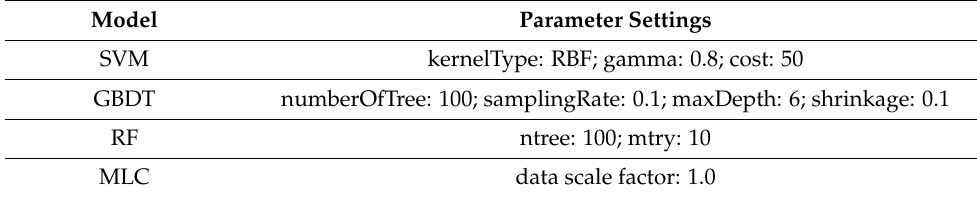
Table 5. The parameter settings of different